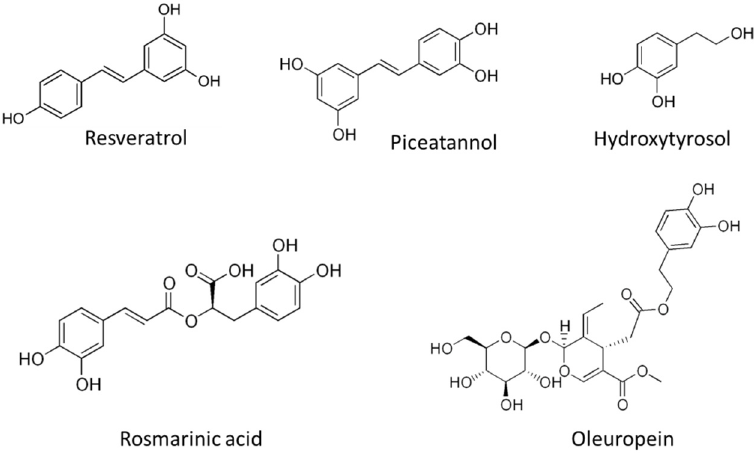
Figure 8. Chemical structures of several polyphenolic compounds found in vegetables, fruits and